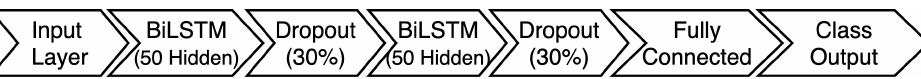
Figure 1. Deep Neural Network Architecture using BiLSTM layers.